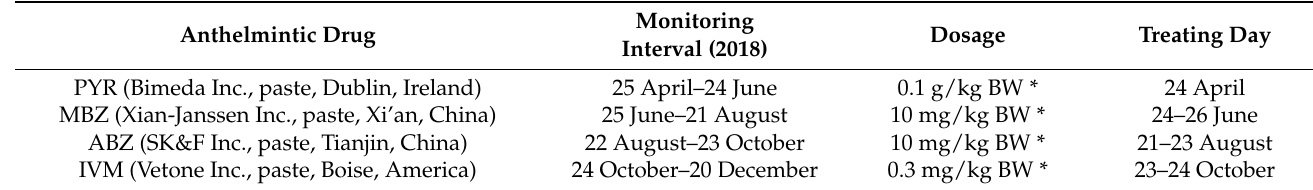
Table 1. Anthelmintic drugs used for treatment of B. schroederi in giant pandas. Anthelmintic Drug